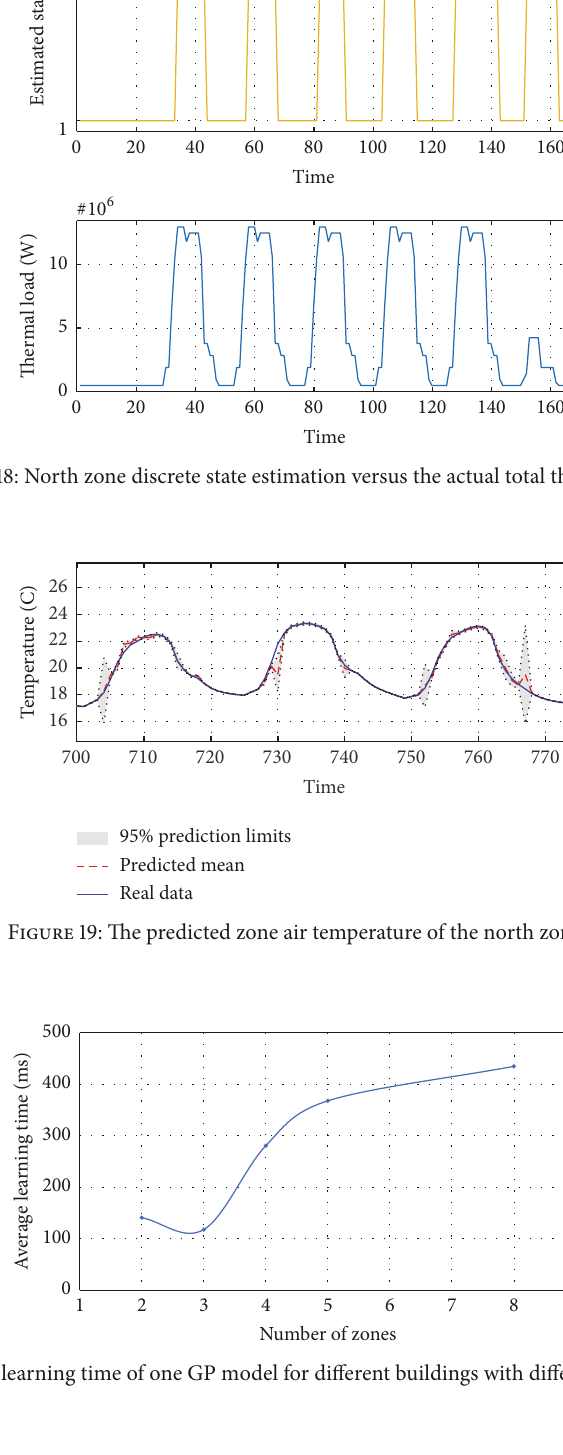
of the proposed model learning approach. The learning process runs online with an adequate computation time. The average learning time for one GP model was 140 ms and